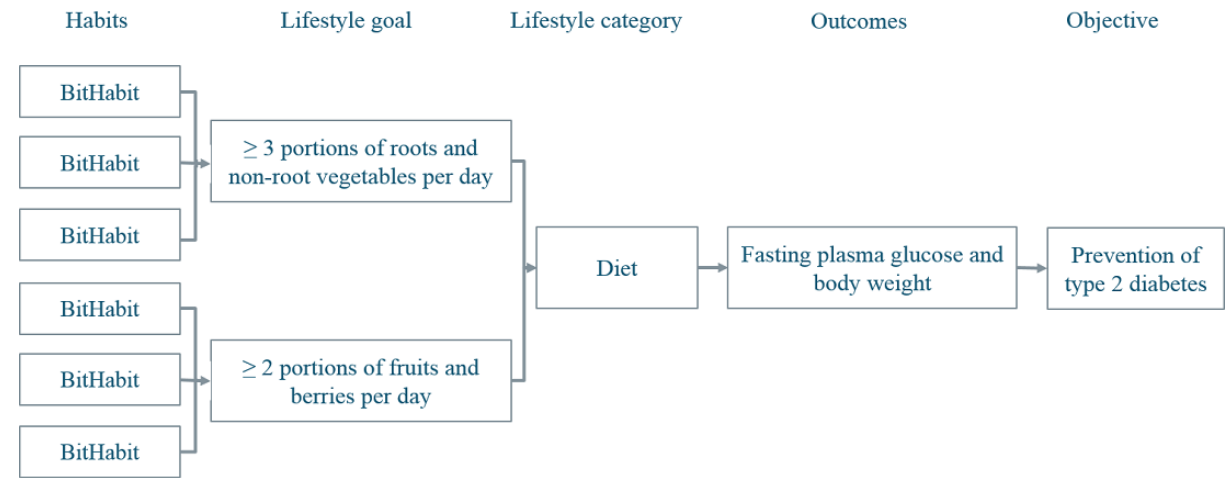
Figure 3. Simplified content-related logic